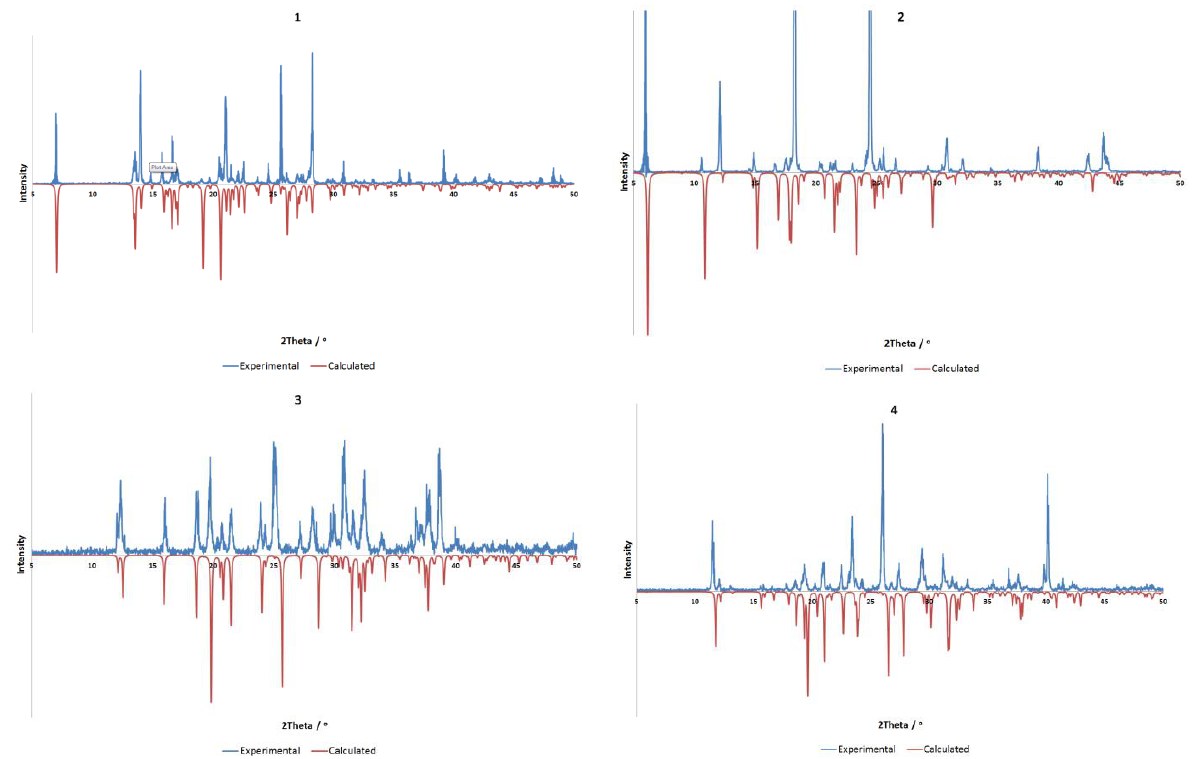
Figure 5. Comparison of experimental (298 K) and calculated (100 K) powder X-ray diffraction data for compounds 1 – 4 . All compounds show good agreement, allowing for minor differences resulting from temperature, with preferred orientation of the experimental sample evident in all